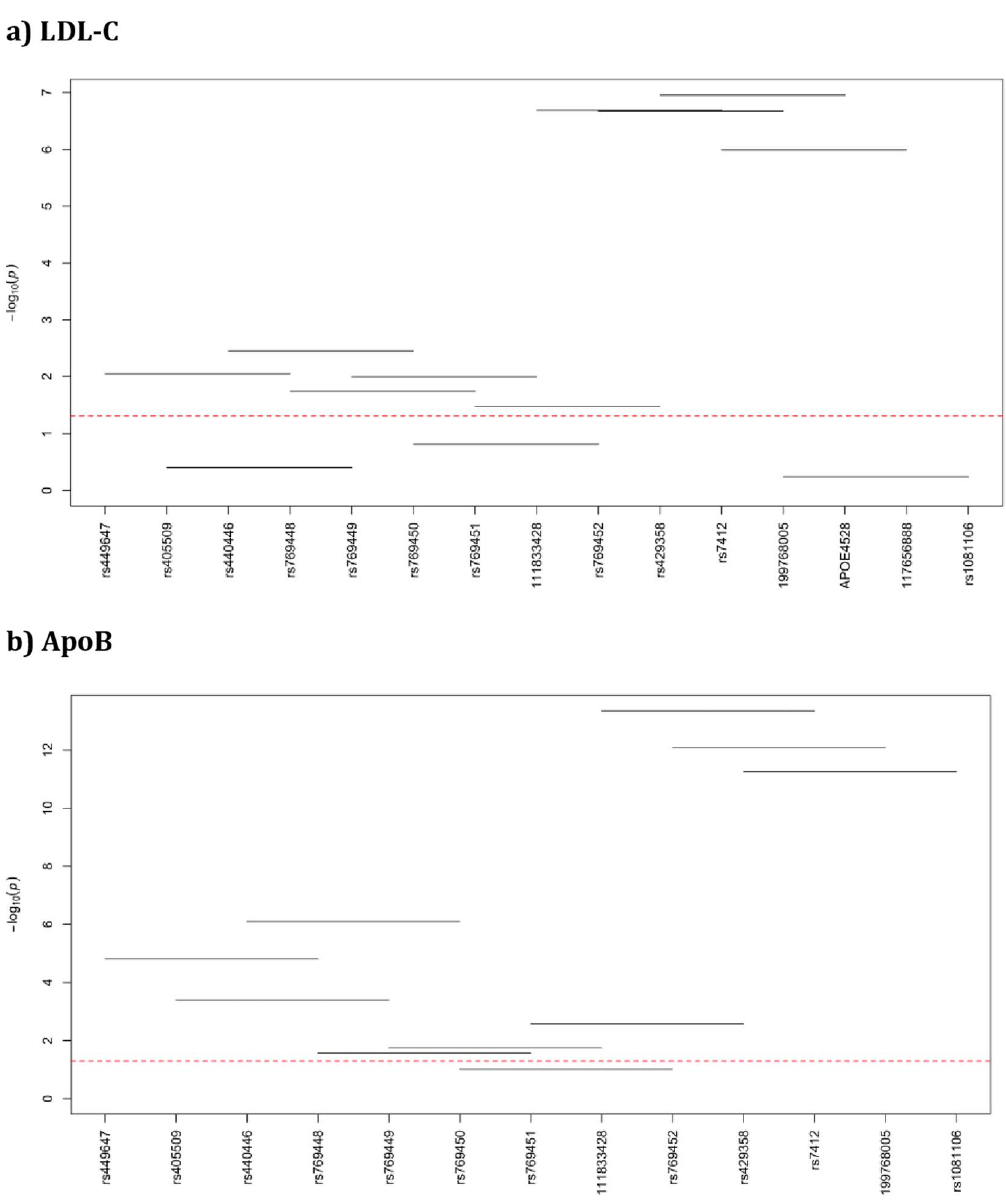
Fig. 3. Haplotype analysis with lipid traits in NHWs. Haplotype windows for LDL-C ( a ), for ApoB ( b ), for HDL-C ( c ), and for TG ( d ). X-axis has the genotyped markers names and the Y-axis has the –log (global p-value), horizontal lines represent the 4-SNP windows, red-line represents the p-value threshold (p 5 0.05) and everything below the threshold is considered non-significant and vice